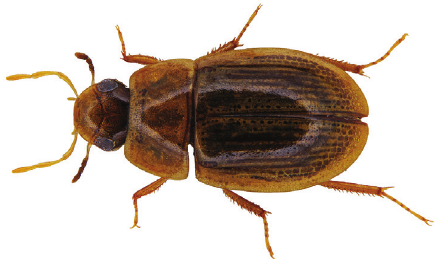
Figure 32. Helochares sp. 2 2.9 mm, iSimangaliso Wetland Park, False Bay (site 27), January 2015 DT Bilton, MS Bird & R Perissinotto